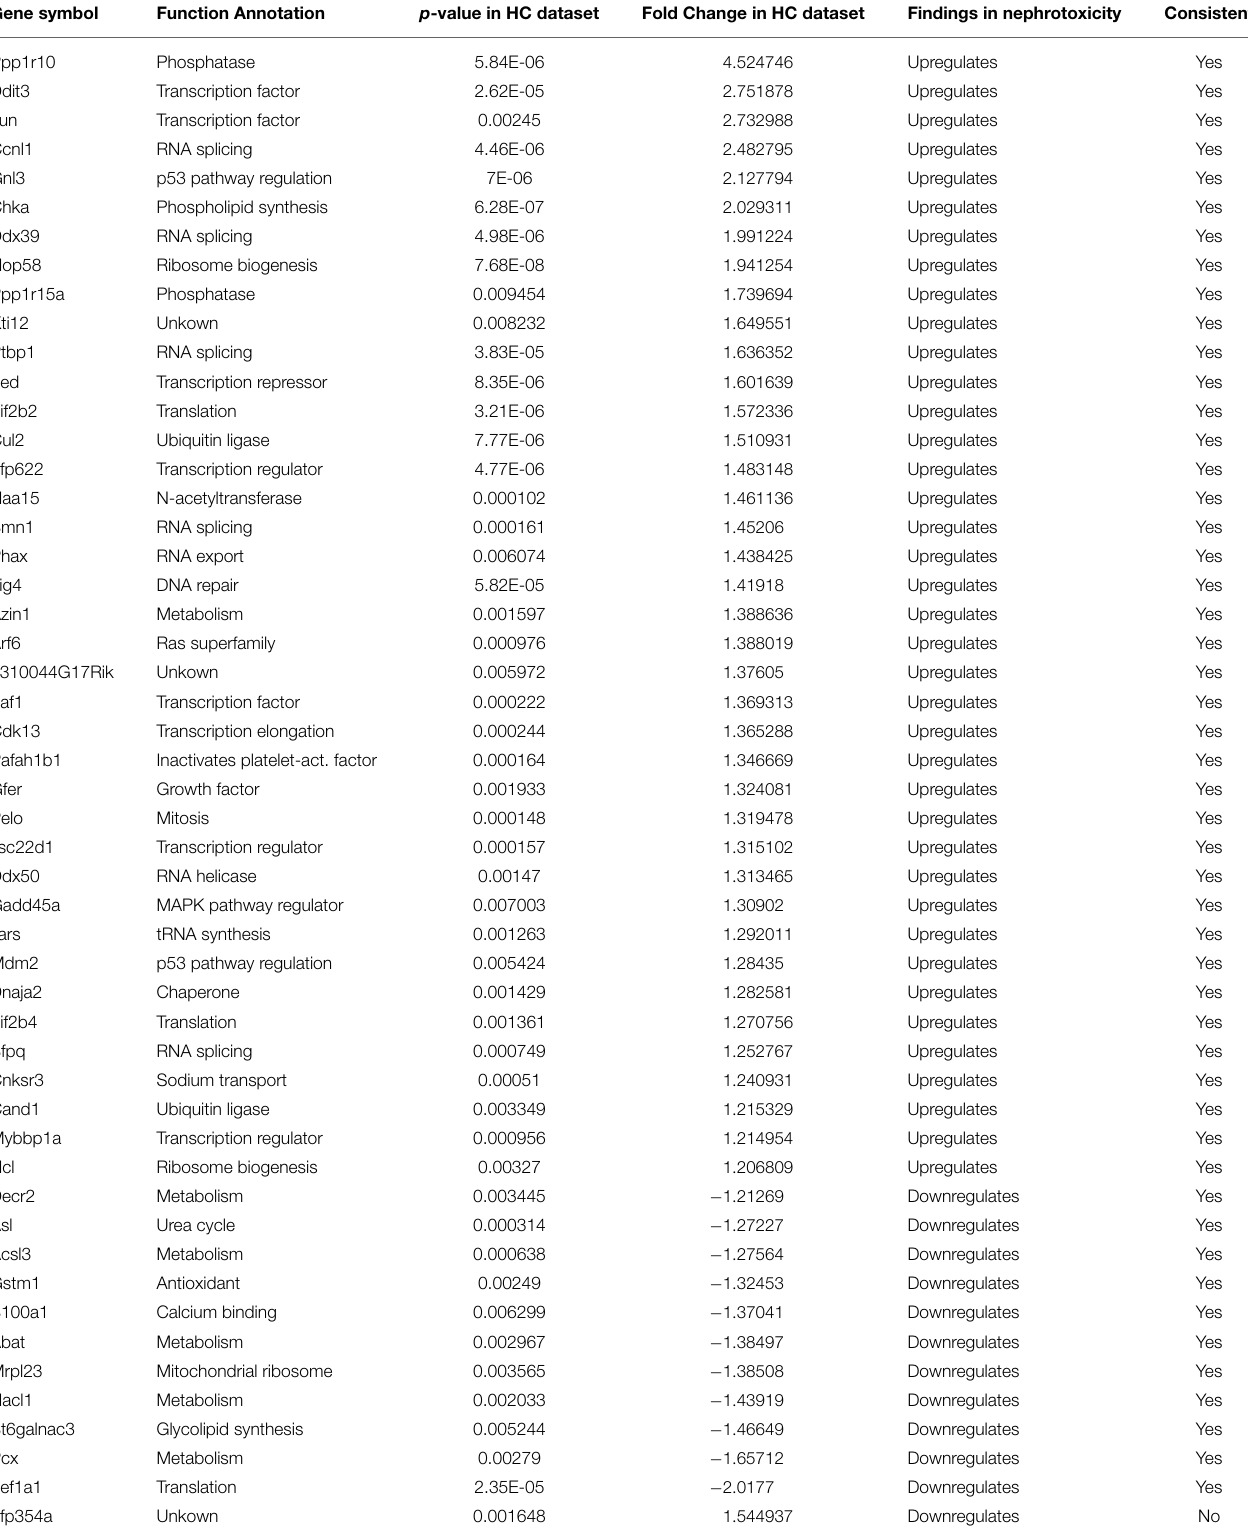
TABLE 5 | Comparison of gentamicin-induced hair cell gene expression changes with gentamicin-induced expression changes in kidney. Gene symbol Function Annotation p -value in HC dataset Fold Change in HC dataset Findings in nephrotoxicity